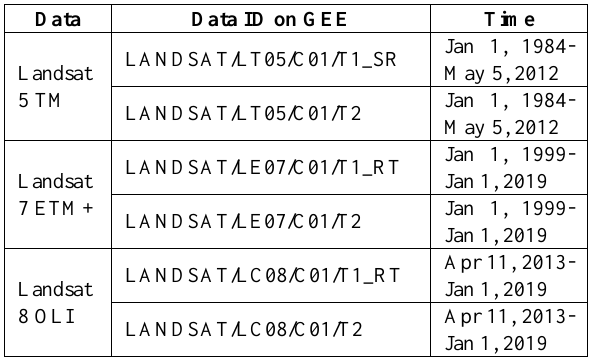
Table 1. Data used in this